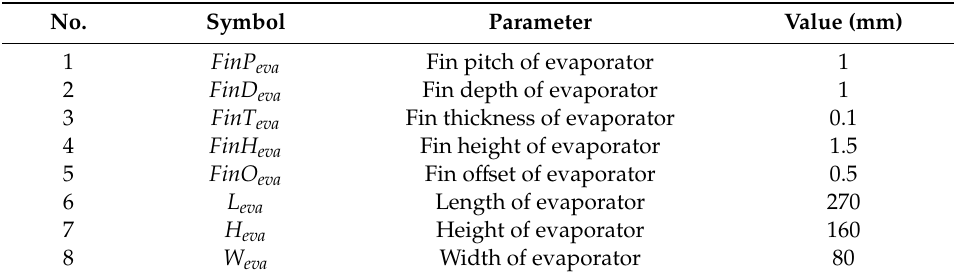
Table 4. Structural parameters of condenser.